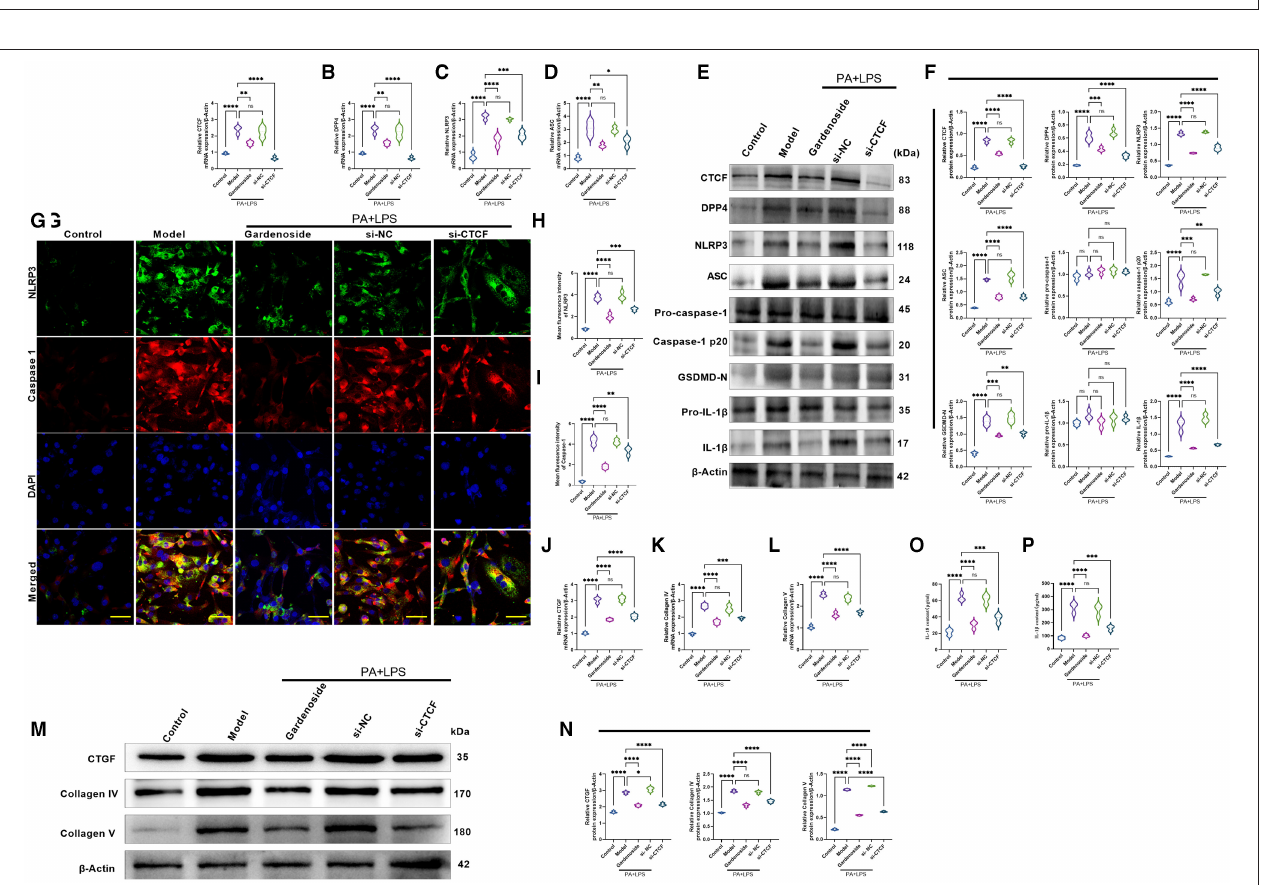
FIGURE 4 | Gardenoside and CTCF silencing inhibited the activation of NLRP3 inflammasome, caspase1-induced pyroptosis, and fibrosis pathways in hepatocytes. (A) RT-qPCR detection of the relative mRNA expression of CTCF in AML cells in indicated groups. (B) RT-PCR detection of the relative mRNA expression of DPP4 in AML cells in indicated groups. (C) RT-PCR detection of the relative mRNA expression of NLRP3 in AML cells in indicated groups. (D) RT-PCR detection of the relative mRNA expression of ASC in AML cells in indicated groups. (E) Representative bands of Western blot detection of the relative protein expression of CTCF, DPP4, NLRP3, ASC pro-caspase-1 p20, caspase-1 p20, GSDMD-N, pro-IL-1 β , and IL-1 β in AML cells in indicated groups. (F) Densitometry analysis of bands of Western blot detection of the relative protein expression of CTCF, DPP4, NLRP3, ASC pro-caspase-1 p20, caspase-1 p20, GSDMD-N, pro-IL-1 β , and IL-1 β in AML cells in indicated groups. (G) Representative images of immunofluorescence analysis of NLRP3 and Caspase-1 expression in AML cells in indicated groups (scale bar: 50 µ m). (H) Quantification of immunofluorescence intensity of NLRP3 expression in different groups as determined by immunofluorescence analysis. (I) Quantification of immunofluorescence intensity of caspase-1 expression in different groups as determined by immunofluorescence analysis. (J) RT-qPCR detection of the relative mRNA expression of the fibrosis marker CTGF in AML cells in indicated groups. (K) RT-qPCR detection of the relative mRNA expression of the fibrosis marker Collagen IV in AML cells in indicated groups. (L) RT-qPCR detection of the relative mRNA expression of the fibrosis marker Collagen V in AML cells in indicated groups. (M) Bands of Western blot detection of the relative protein expression of the fibrosis markers CTGF, Collagen IV and Collagen V in AML cells in indicated groups. (N) Densitometry analysis of bands of Western blot detection of the relative protein expression of the fibrosis markers CTGF, Collagen IV and Collagen V in AML cells in indicated groups. (O) ELISA detection of the protein level of IL-18 in indicated groups. (P) ELISA detection of the protein level of IL-1 β in indicated groups. ns, non-significant, * p < 0.05, ** p < 0.01, *** p < 0.001, and **** p < 0.0001 in the comparison between the indicated groups.